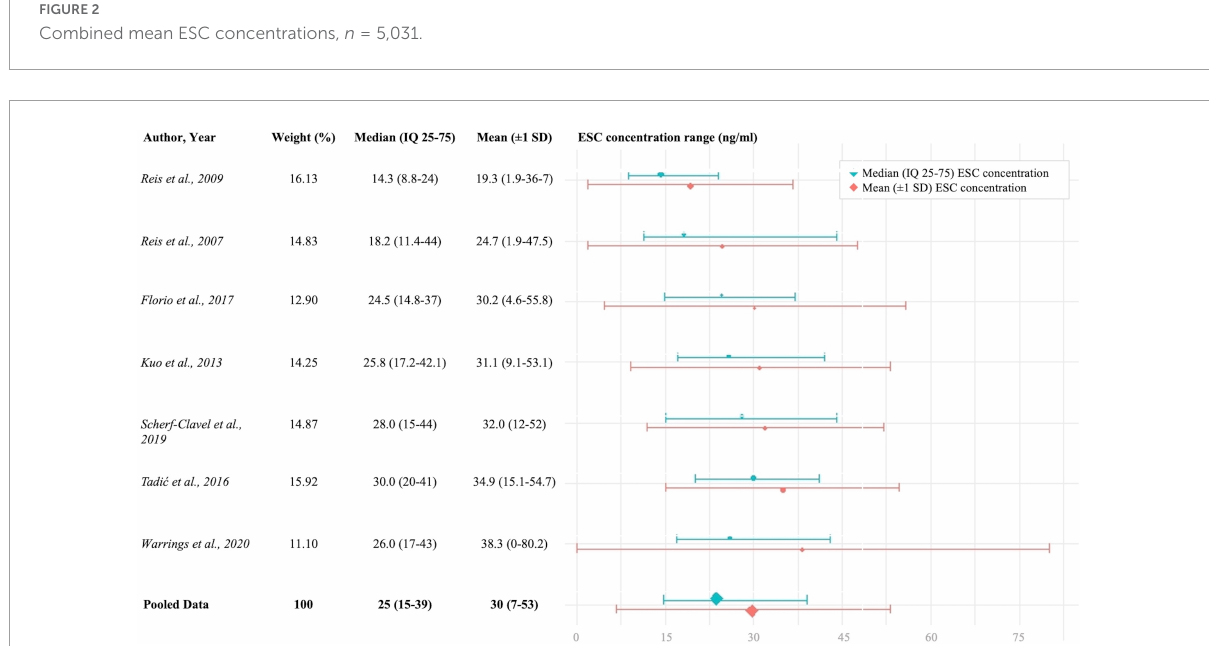
FIGURE3 Combined ESC mean ± 1 SD and interquartile concentration ranges, n =